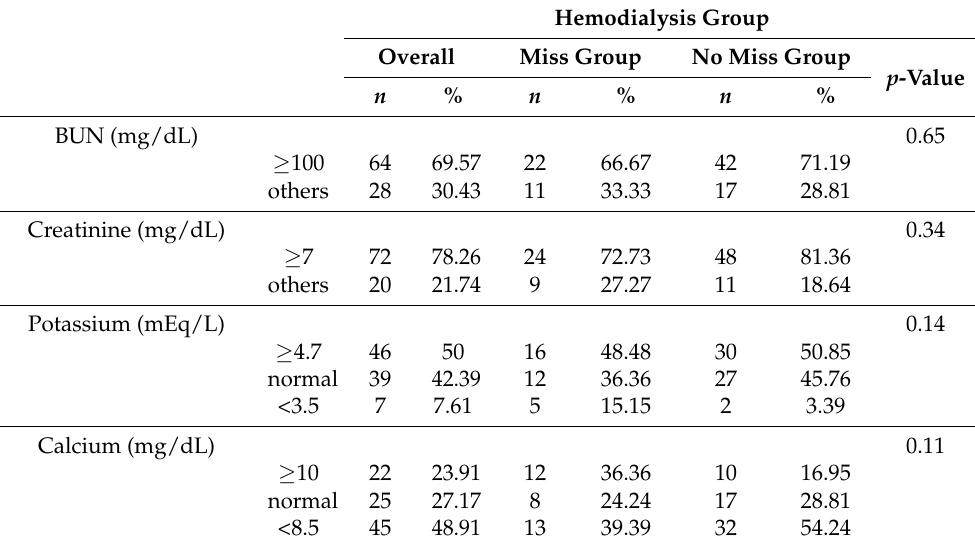
Table 4. Blood test results among the study participants ( n =